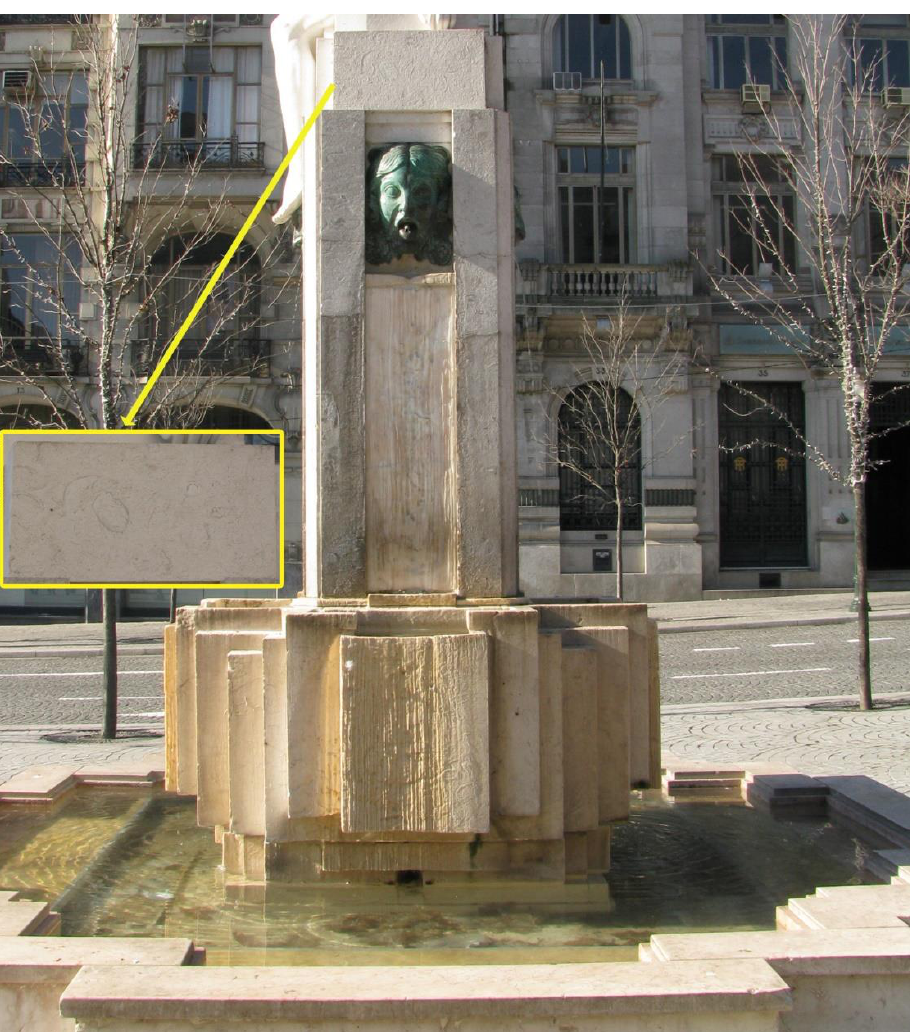
Figure 7. View of the east side of the pedestal of the Youth statue in Porto (NW Portugal – a town located on granite terrains) with inset showing the fossils.